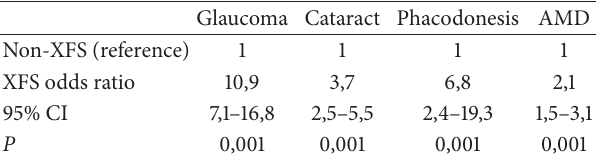
Table 4: Relationship between XFS and glaucoma, cataract, pha- codonesis, and